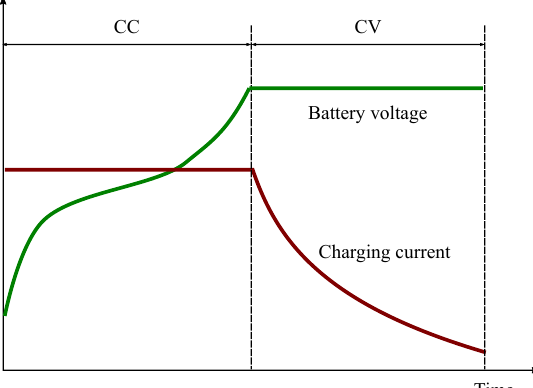
Figure 12. Current and voltage evolution during the CC-CV charging.